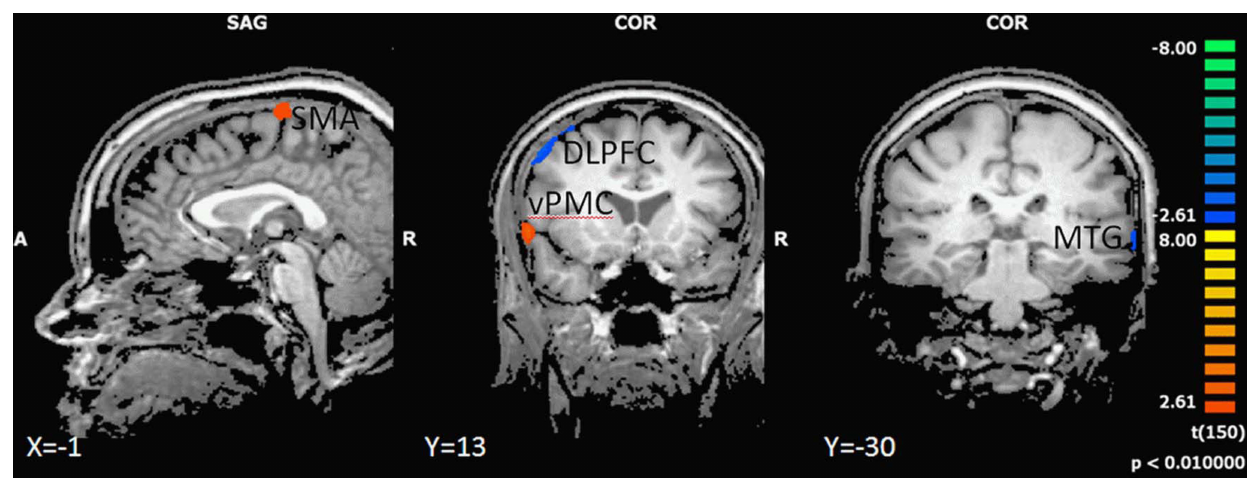
Negative t-values indicate decreased activation during imagination. BA, Brodmann area; IPC, inferior parietal cortex; PrCG, precentral gyrus; DLPFC, dorsolateral prefrontal cortex; SMA, supplementary motor area; MTG, middle temporal gyrus.